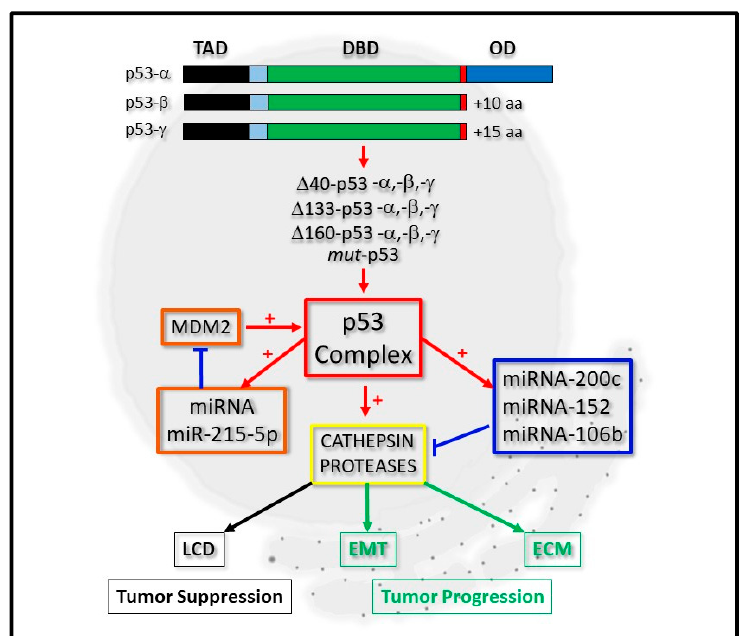
Figure 1. Integrative regulation of cathepsin proteases by p53 and micro-RNA expression. P53-alpha (p53- α ) can be expressed as p53-beta (p53- β ) or p53-gamma (p53- γ ) isoform proteins, which lack the oligomerization domain (OD). Derivatives of these, which lack the complete Transactivation domain (TAD), but retain the DNA-binding domain (DBD), can also be expressed as ∆ 40-p53, ∆ 133-p53, ∆ 160-p53 or mut -p53 forms. The p53 complex can be regulated by micro-RNA (miRNA) expression through a positive feedback loop by positively regulating miRNA-215-5p, which negatively regulates MDM2 protein levels (orange boxes). It can transcriptionally regulate cathepsin protease expression directly or indirectly through directly regulating the expression of miRNA-200c, for example (blue box). Cathepsin protease expression (yellow box) contributes to lysosomal-mediated cell death (LCD) as a tumor suppressor (black boxes) or cell differentiation through Epithelial-Mesenchymal Transition (EMT) and the Extracellular Matrix (ECM) during tumor progression (green boxes).